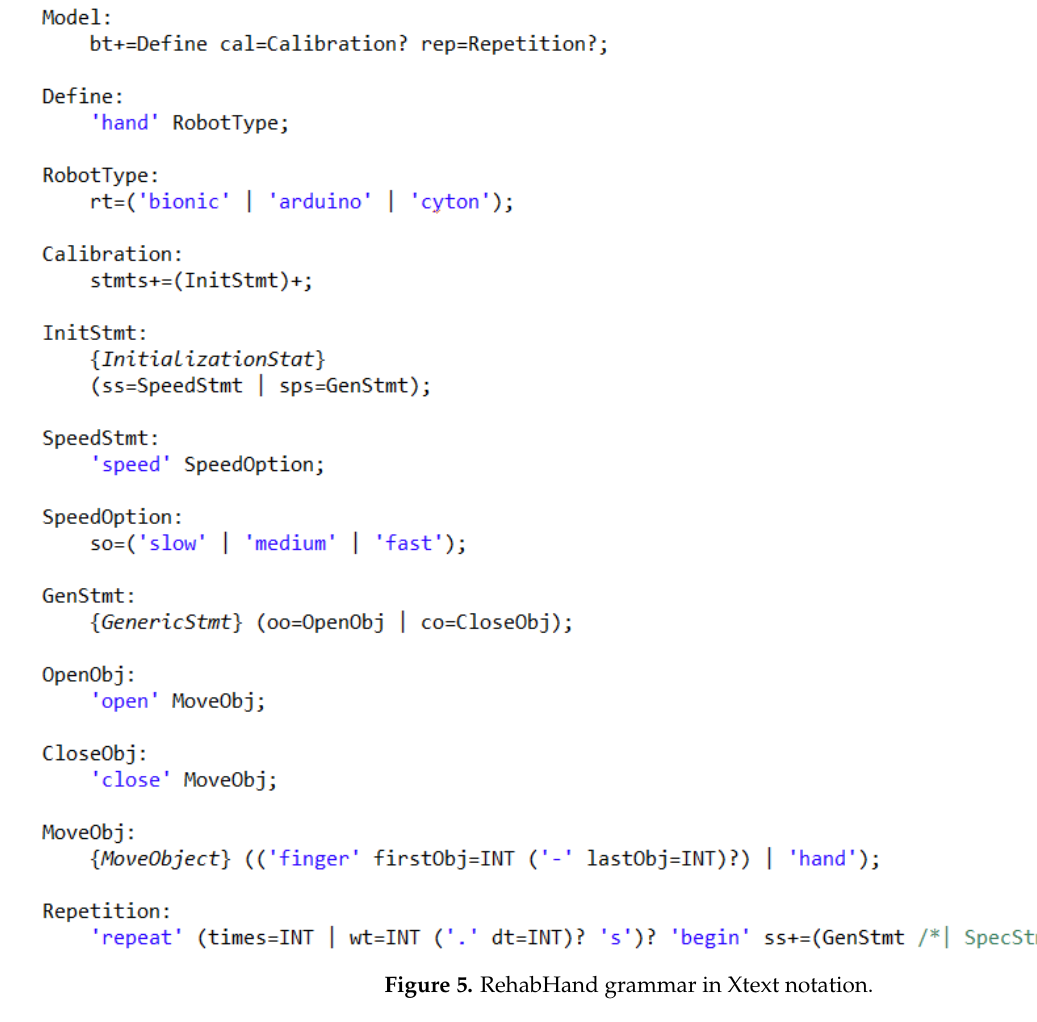
Figure 5. RehabHand grammar in Xtext